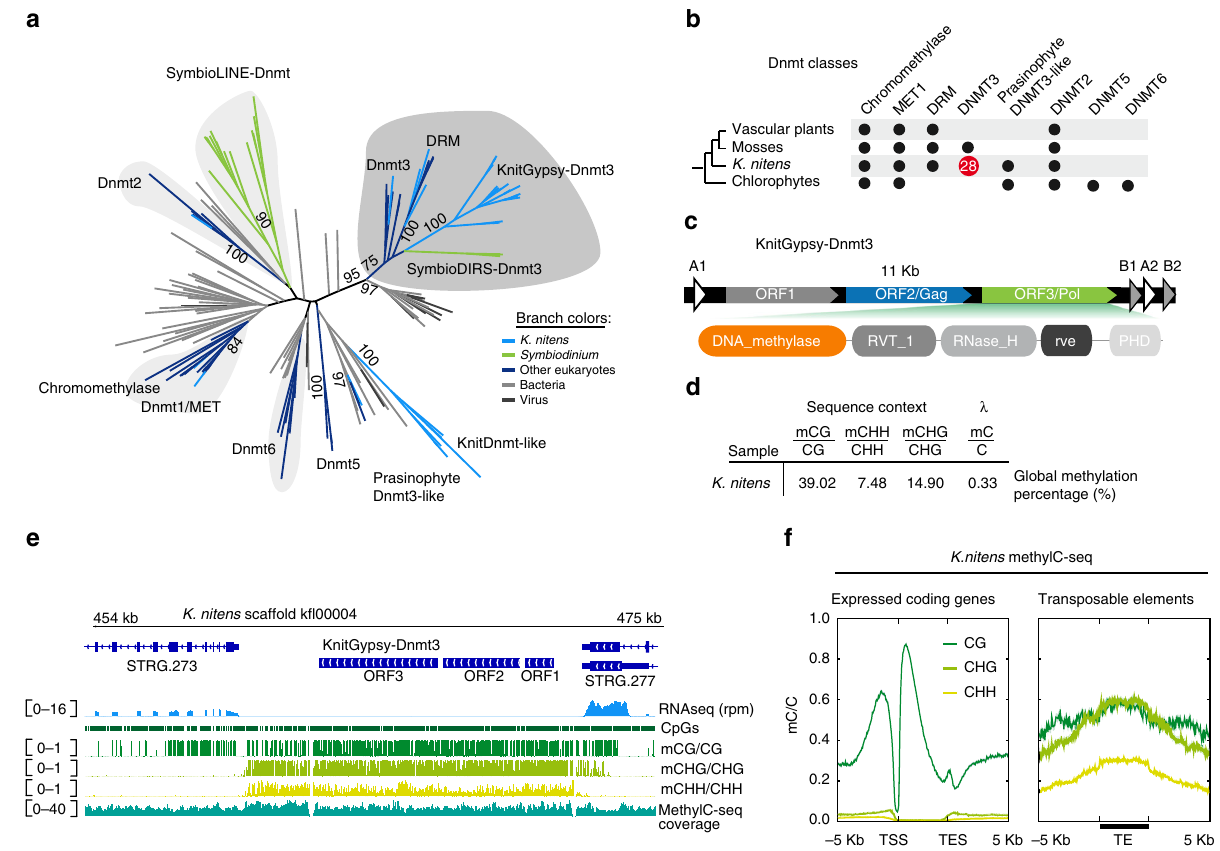
Fig. 4 Independent Dnmt3 acquistion into K. nitens retrotransposons. a Maximum likelihood phylogenetic tree of eukaryotic DNMTs including K. nitens orthologs. b Distribution of DNMT classes in the viridiplantae, in red copy number of Dnmt3 found in K. nitens . c Structure of K. nitens retrotransposons that encode for DNMTs and domain architectures of the ORFs. The structure of repeats is the same as that of a DIRS retrotransposon, but the domain composition is typical of Gypsy retrotransposons. d Percentage of methylated cytosines in distinct sequence contexts in K. nitens MethylC-seq library. e Genome browser display showing the pro fi le of cytosine methylation in CG, CHH and CHG contexts on KnitGypsy-Dnmt3 retrotransposons. rpm reads per million. f Methylation pro fi les in CG, CHH and CHG contexts on K. nitens genes and transposable elements. Line represents mean and pale shade represents standard error of the mean. TSS transcriptional start site, TES transcriptional end site, TE transposable